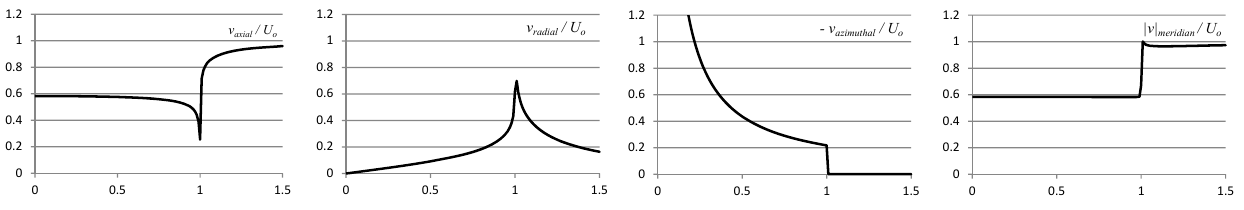
p v x 2 + v r 2 . The horizontal axis